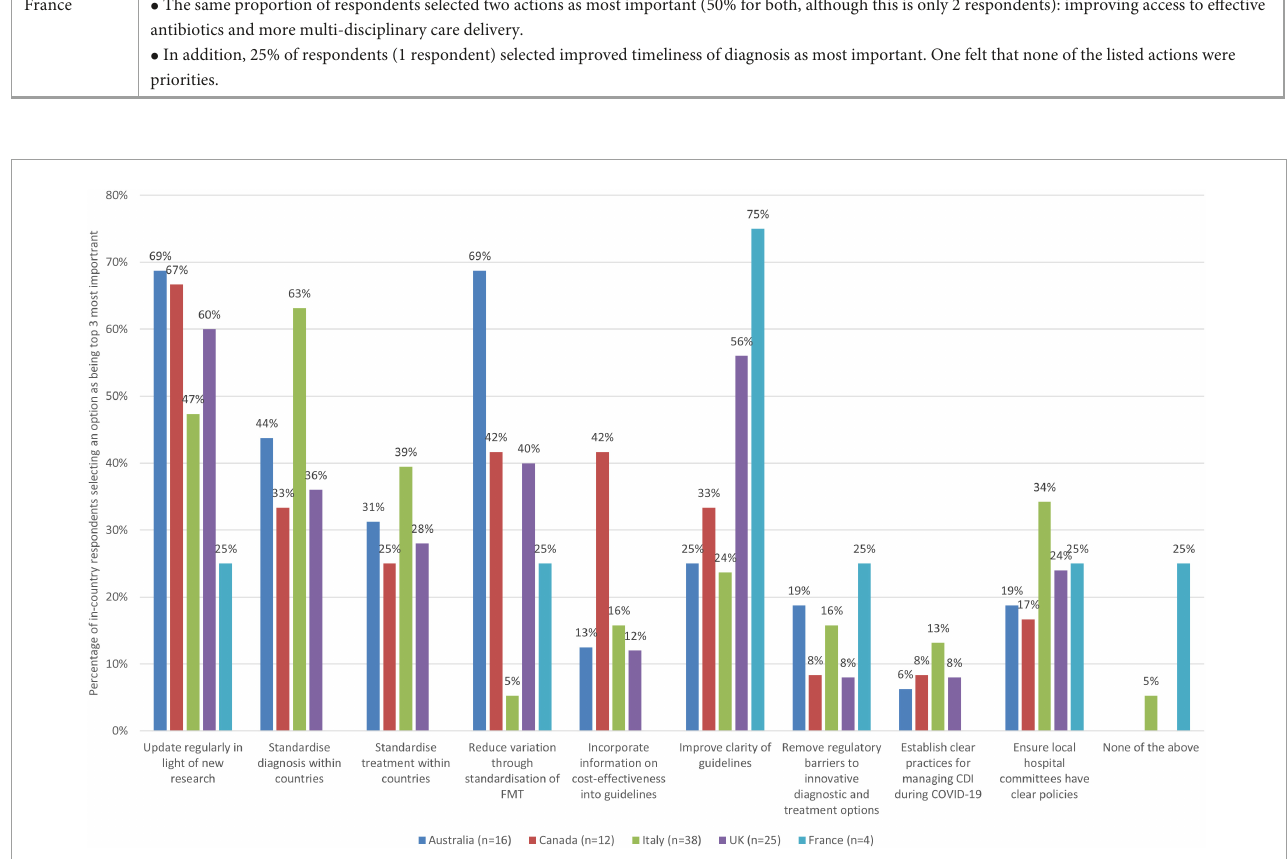
FIGURE3 The improvement actions related to guidelines and regulation for CDI treatments that are the most important (bars represent the percentage of respondents that rated each improvement action as one of the most important by country).